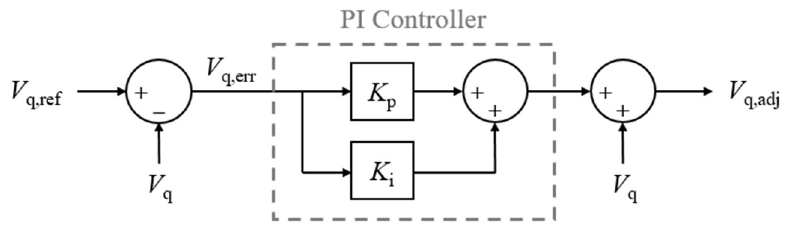
Figure 8. Inverter control unit of the PI-based BC.